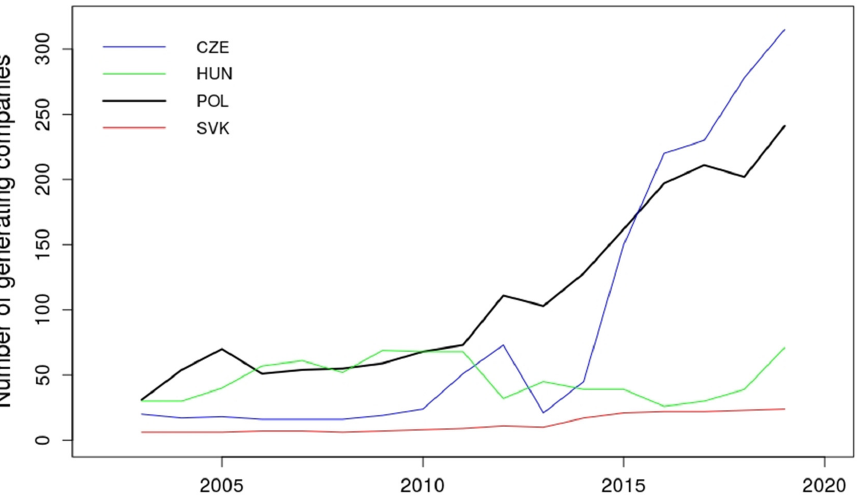
Figure 5. Economic power in the energy market (2004–2019). Source: EUROSTAT [38].